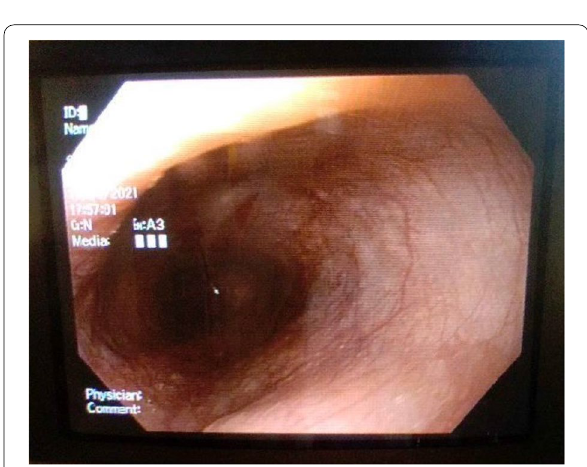
Fig. 3 Upper gastrointestinal endoscopy showed an absence of esophageal